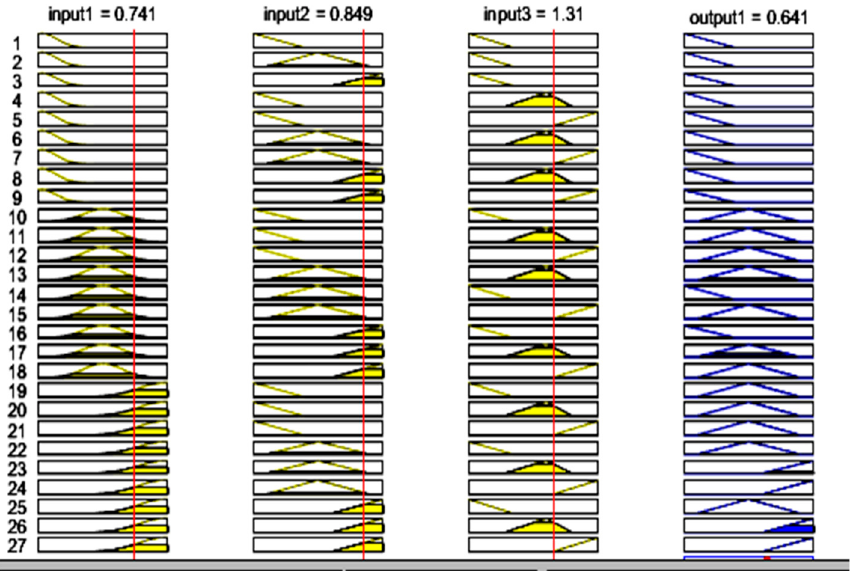
Figure 6. Display of single point simulation after optimization of the FCM algorithm.